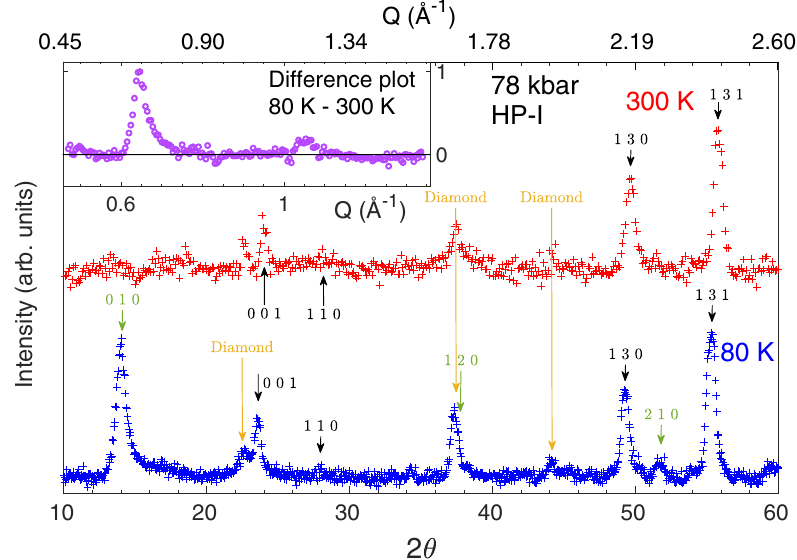
FIG. 4. Powder neutron diffraction patterns of FePS 3 at 78 kbar, at 80 and 300 K taken on D20, ILL. Nuclear and magnetic Bragg peaks are marked as indexed in the monoclinic HP-I phase, and peaks due to the diamond anvils are marked in orange. The magnetic propagation vector is k ¼ ð 0 ; 1 ; 0 Þ and is characterized by a sharp symmetric Bragg peak. Additional magnetic peaks are seen at 1 2 0 [ k ¼ ð 0 ; 1 ; 0 Þ þ ð 1 1 0 Þ ] and 2 1 0 [ k ¼ ð 0 ; 1 ; 0 Þ þ ð 2 0 0 Þ ] from the combination of magnetic and nuclear scattering. The inset shows the result of subtracting the 300 K data from the 80 K plotted against Q .